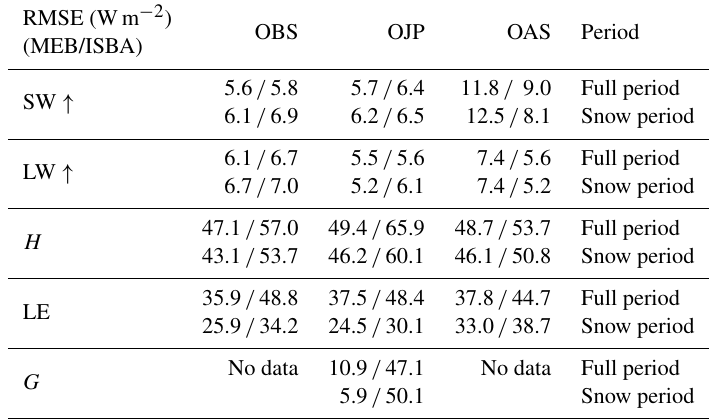
Table 3. RMSE for the ISBA-MEB and ISBA experiments for fluxes SW ↑ , LW ↑ , H , LE, and G calculated over half-hourly data.